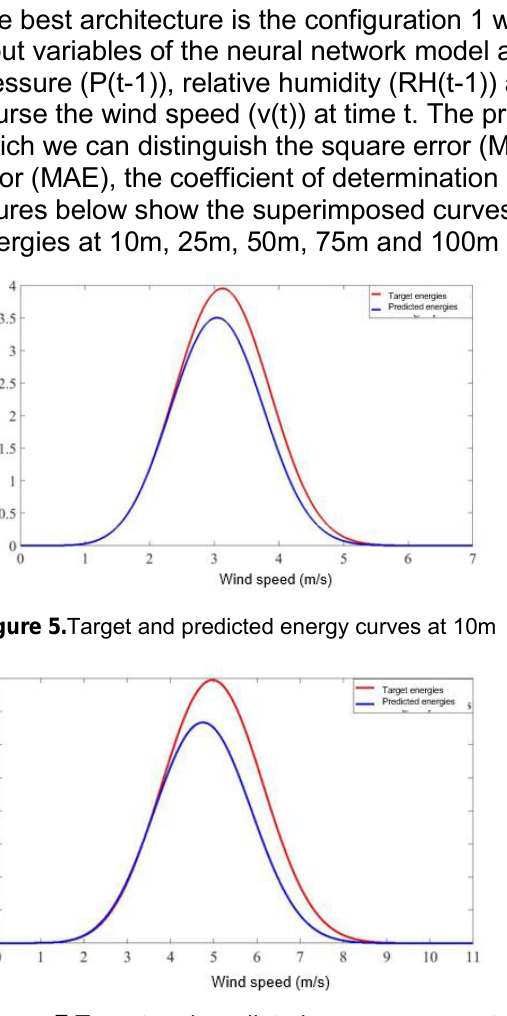
Figure 8. Target and predicted energy curves at